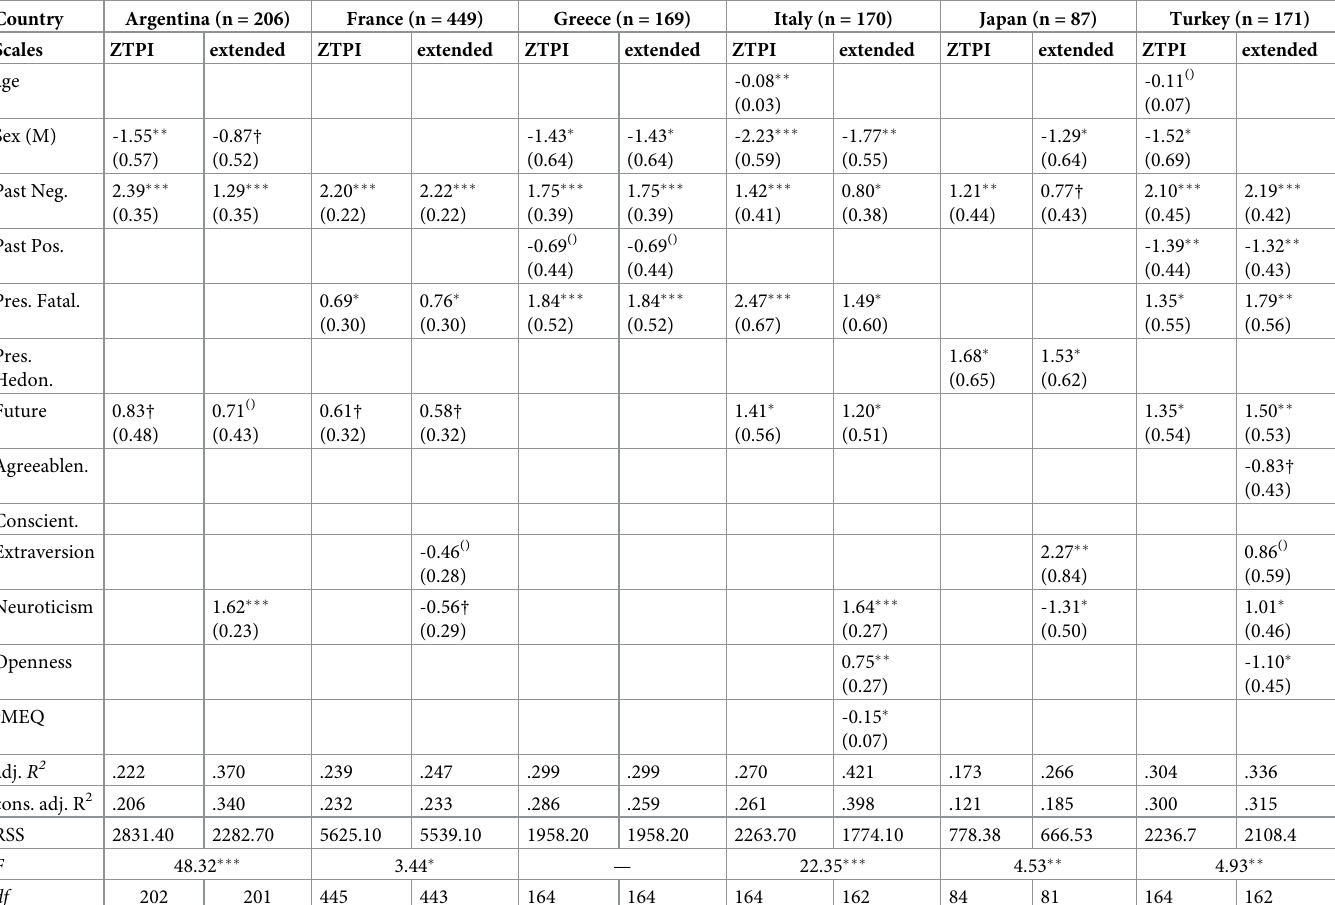
Table 4. Final models for anxiety after stepwise regression (country-wise, with two models each (1 st : ZTPI, sex, and age as predictors; 2 nd -extended: ZTPI, sex, age, BFI, and rMEQ as predictors)). Country Argentina (n = 206)